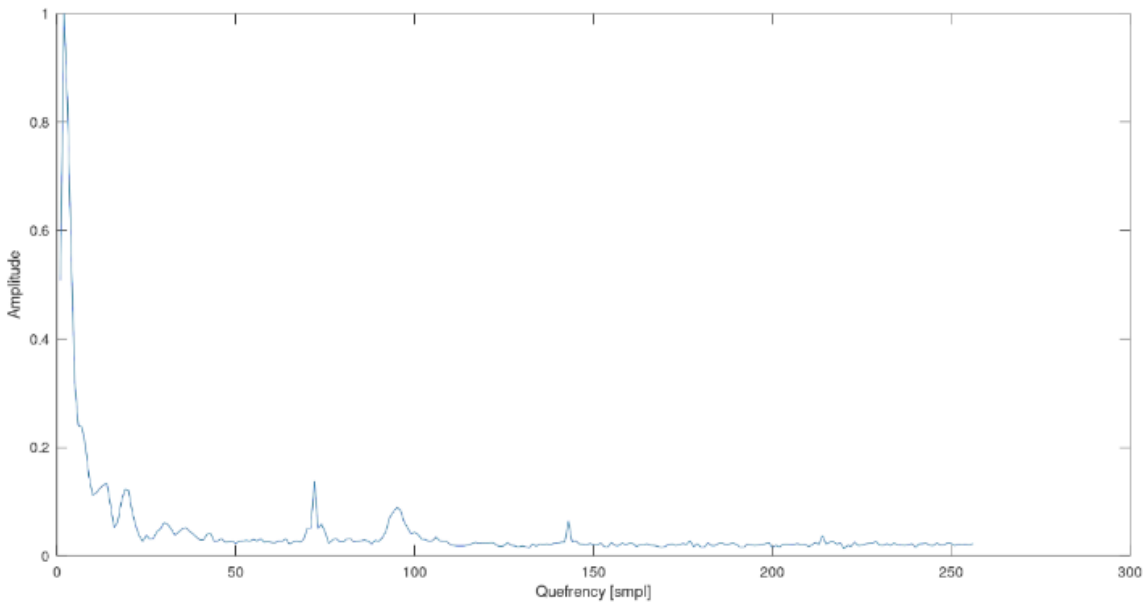
Figure 9. Cepstrum of the phonetic segment “ka”, word barrel (in Polish “beczka”)—the physiological speech of a healthy woman.